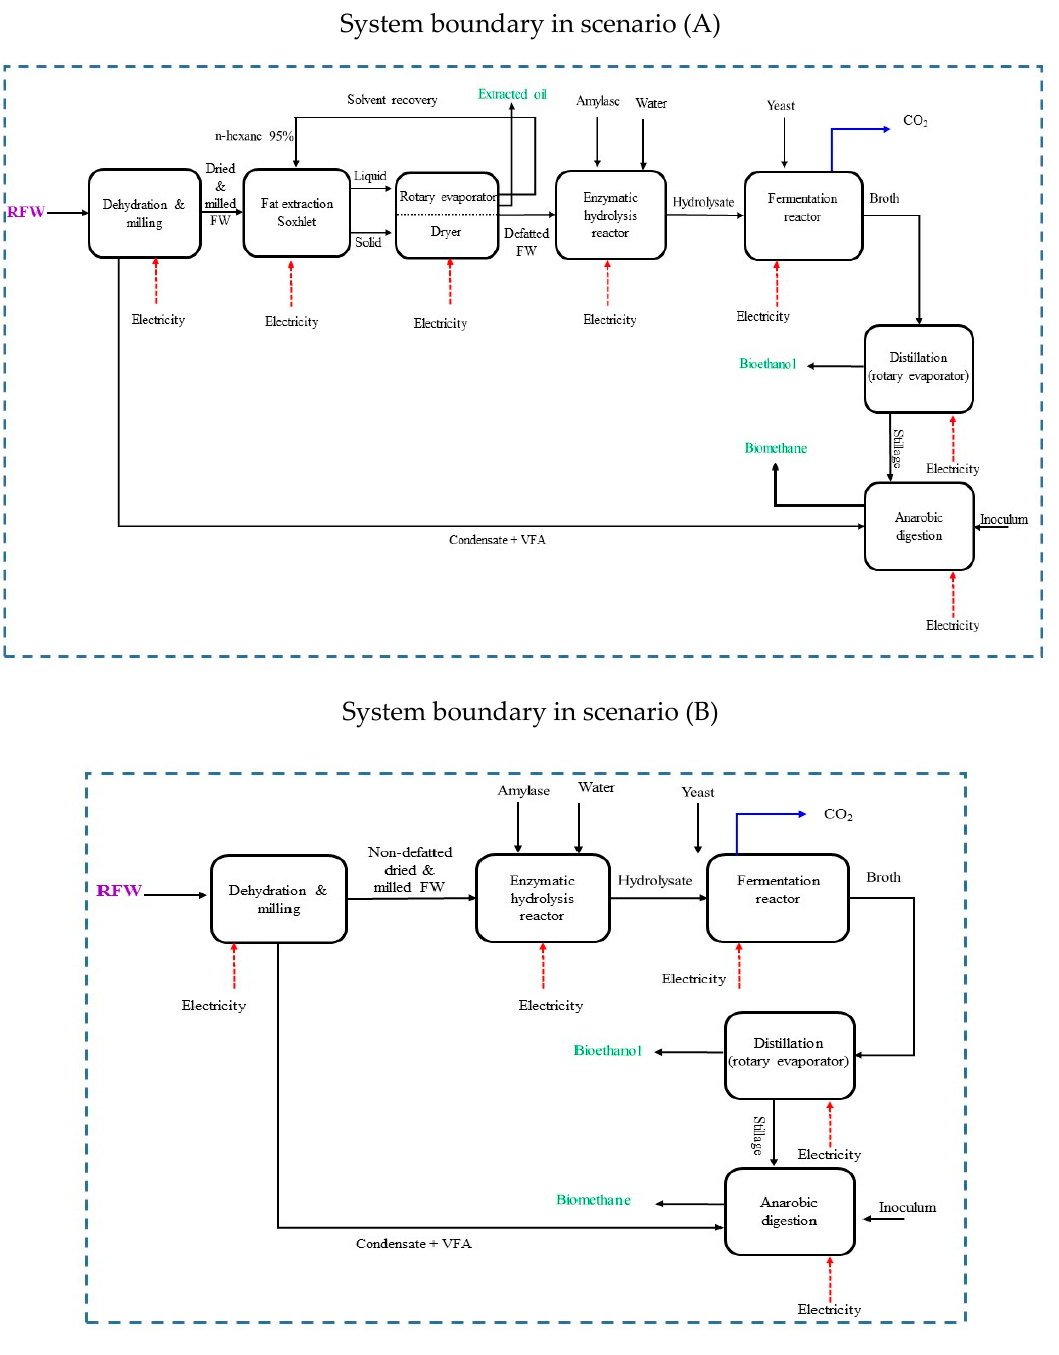
Figure 2. Scenarios (A) and (B). Schematic flowsheet including the gate-to-gate system boundary for food waste valorization.